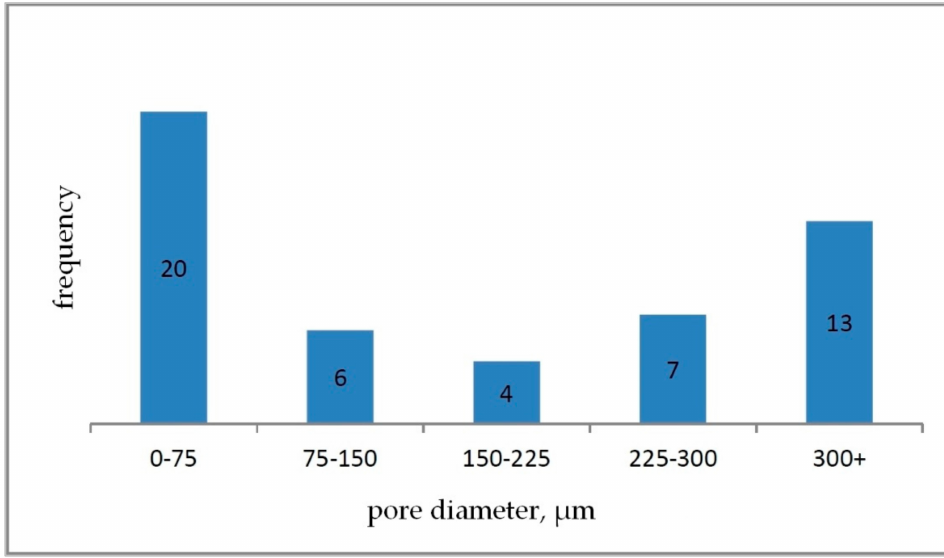
Figure 11. Pore size histogram for carbon sample